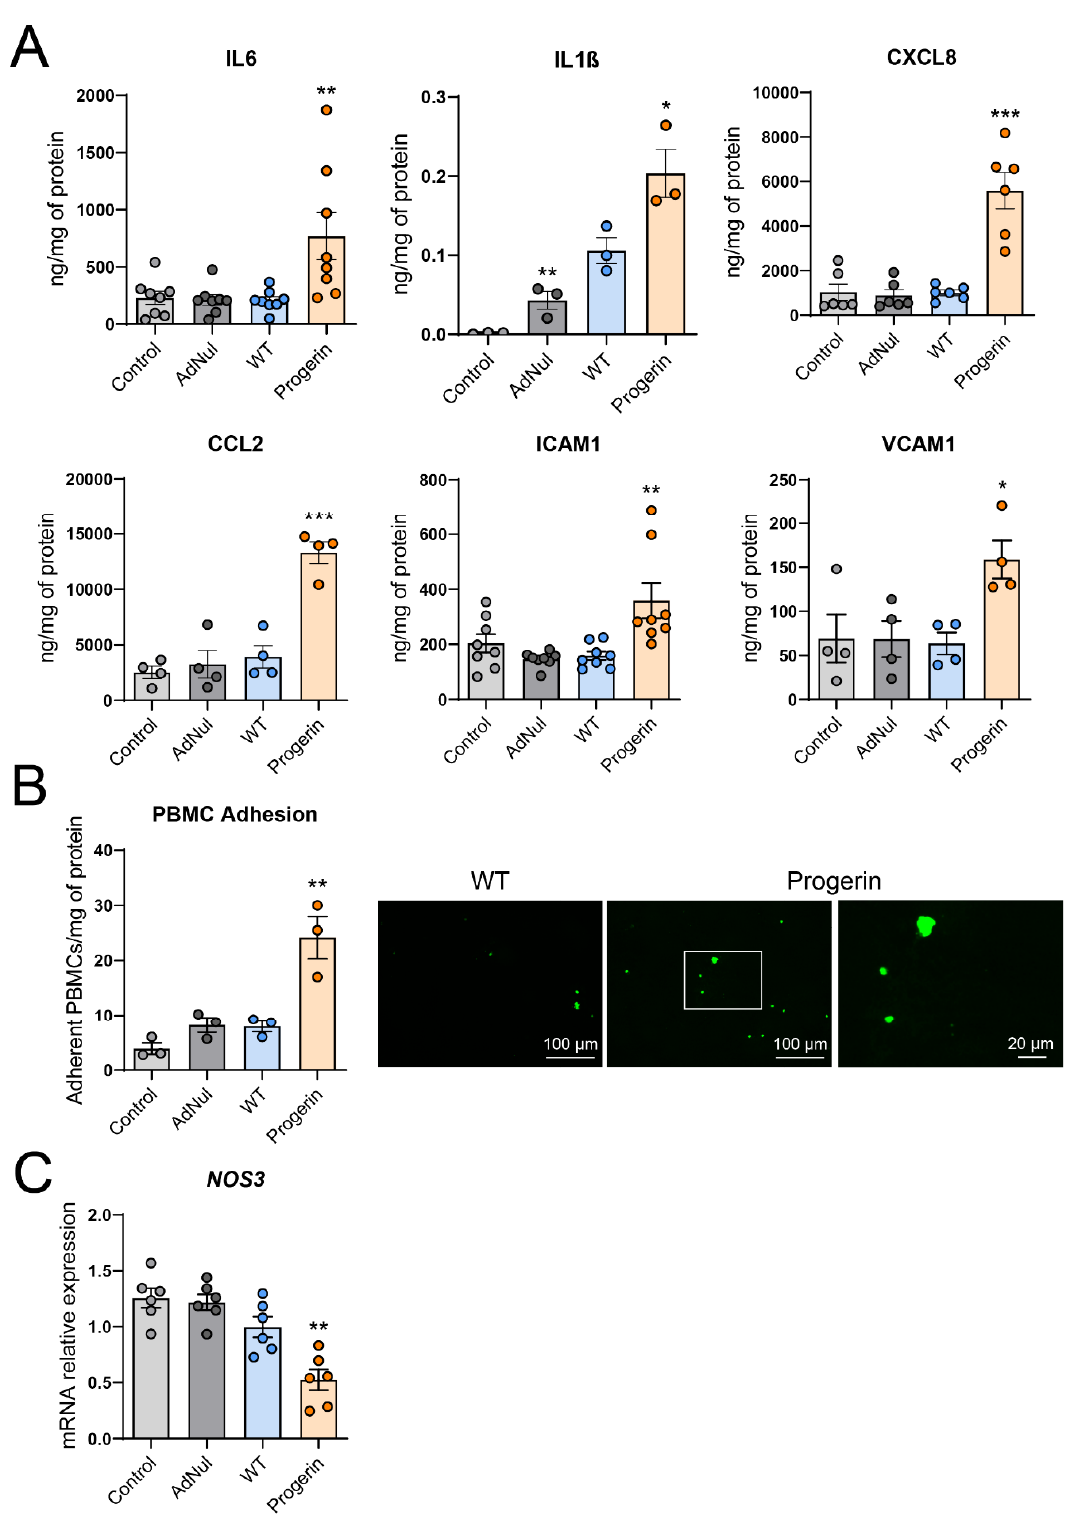
Figure 2. Progerin induces endothelial cells inflammation and dysfunction. Early-confluent HCAECs were transduced or not with Flag-tagged recombinant adenovirus containing WT-prelamin A or progerin for 72 h or with an empty vector. ( A ) Twenty-four hour secretion of the proinflammatory cytokines IL6, IL1 β , of the chemokines CXCL8 and CCL2 and of the adhesion molecules ICAM1 and VCAM1. ( B ) Adhesion assay of peripheral blood mononuclear cells (PBMCs) from healthy donors on transduced and control endothelial cells was quantified as the number of adherent PBMC/mg of